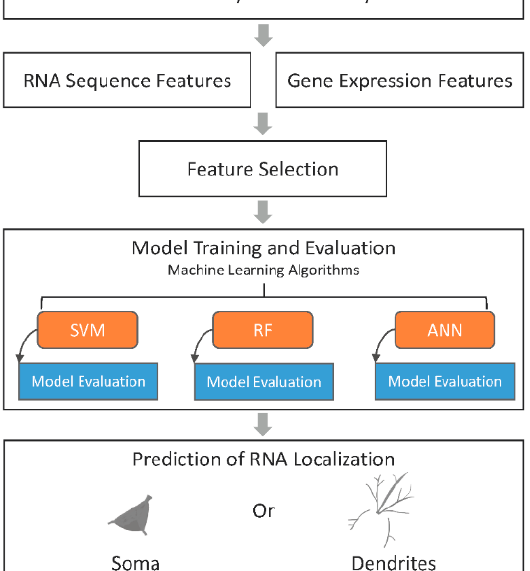
Figure 1. Schematic diagram of PredSynRNA for prediction of synaptically localized RNAs. First, dendritically and somatically localized RNAs were compiled from previous rodent studies. Then, human orthologues were identified and taken as the training instances. Second, features were extracted from RNA sequence and developmental brain gene expression data. Third, feature selection was conducted using a Random Forest-based method. Forth, various machine learning models were constructed and evaluated. Lastly, the best models were applied to the prediction and prioritization of candidate RNAs that may be localized to human synapses.